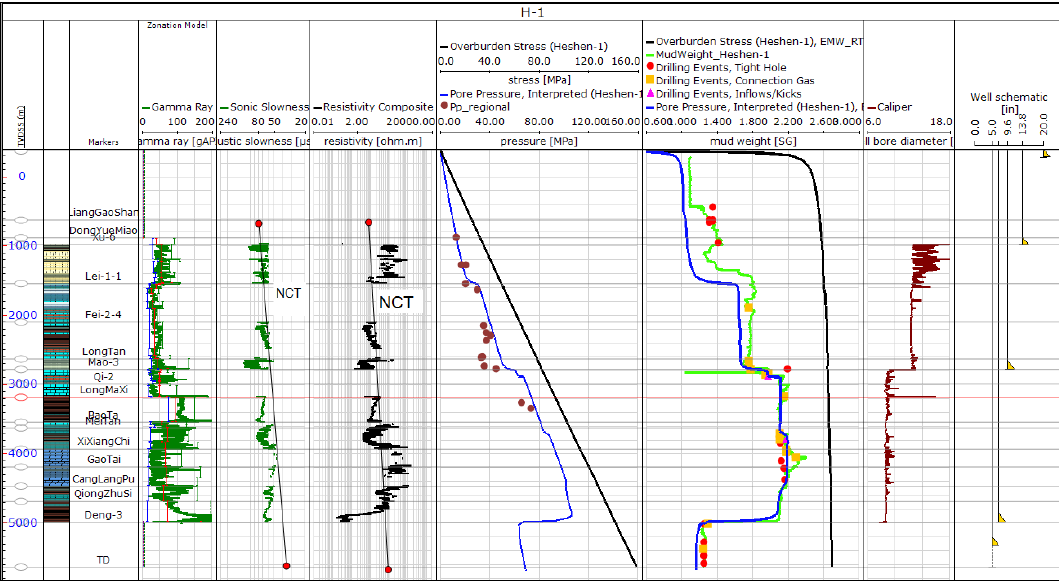
Figure 5. 1D Pore pressure modeling of H1.